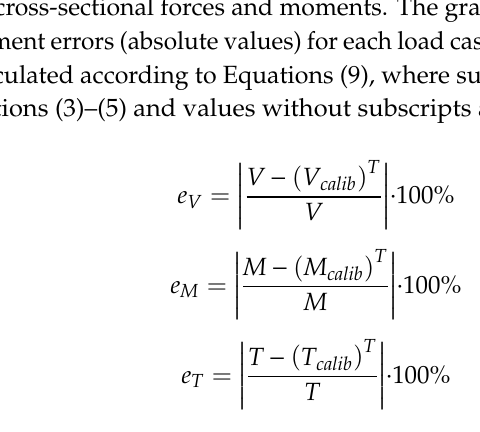
Table 2. Torsional moment measurement errors.